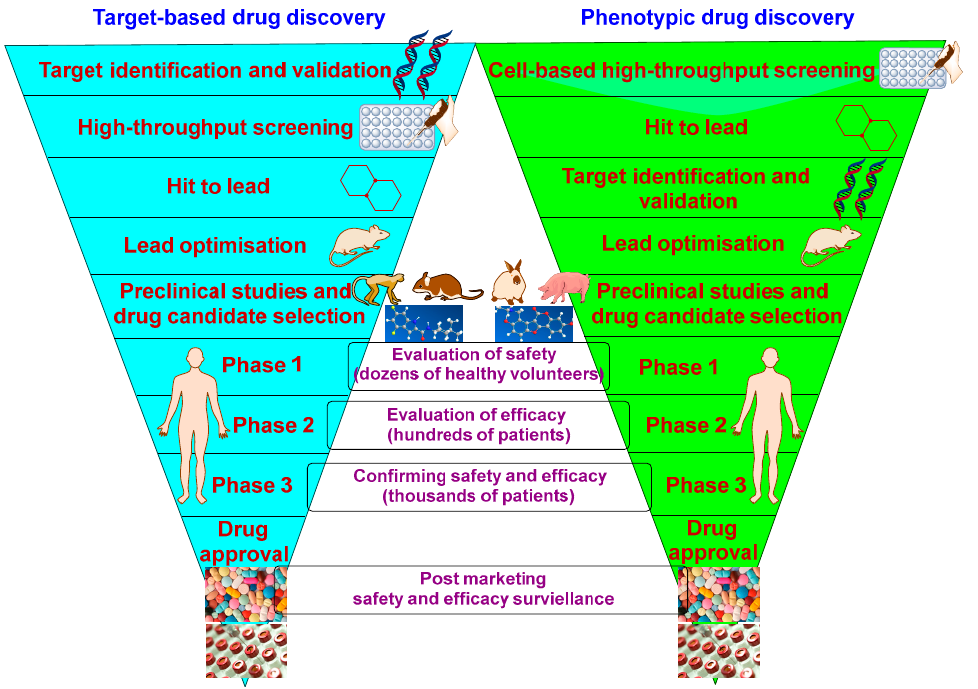
Figure 5 . A simplified diagram of target-based and phenotypic TB drug discovery cascade. Figure 5. A simplified diagram of target-based and phenotypic TB drug discovery